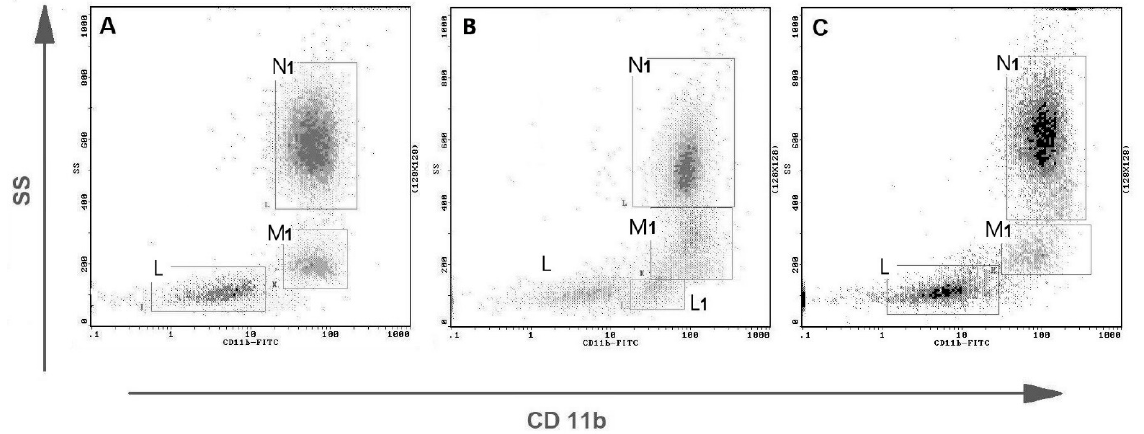
Figure 4. Representative flow cytometric analysis of CD11b+ leukocytes in peripheral blood from female dogs with malignant mammary tumors. Dot plots showing CD11b expression on canine leukocytes from ( A ) the healthy bitch, ( B ) from the bitch with osteosarcoma, and ( C ) the bitch with complex carcinoma G2. Gate N1–CD11b positive neutrophils, M1–CD11b positive monocytes, L–CD 11b negative lymphocytes, L1–CD11b positive lymphocytes (separate CD11b+ subpopulation visible).